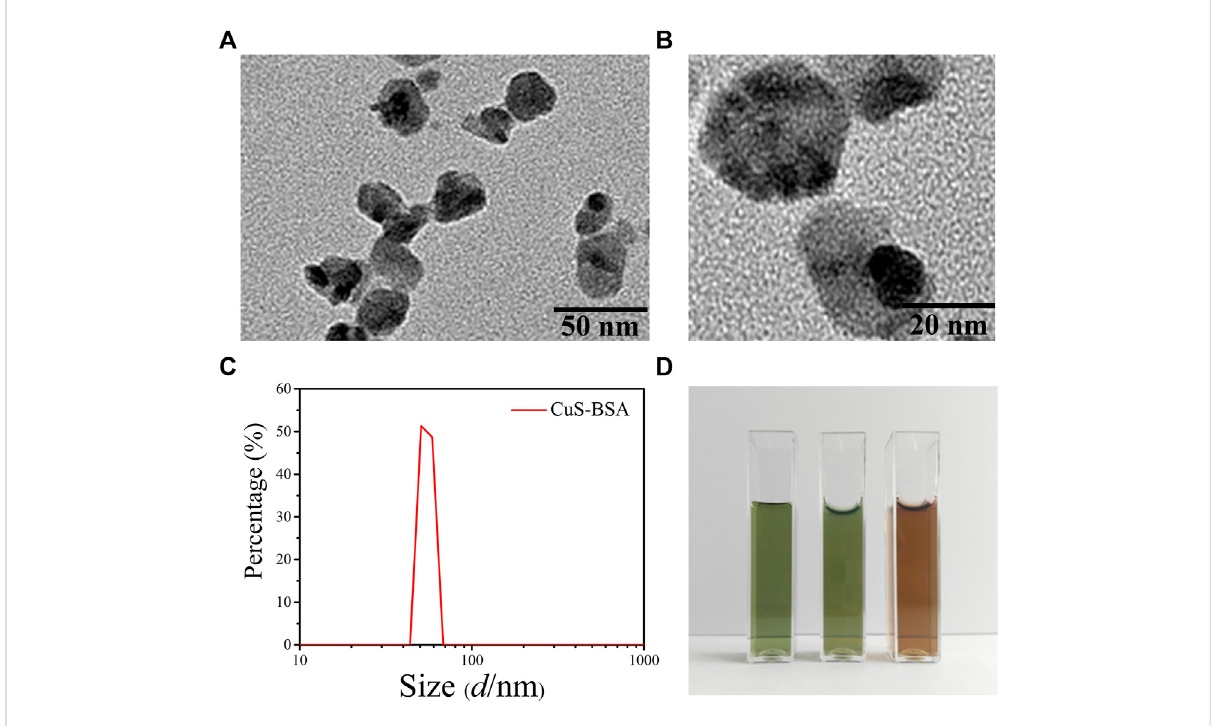
FIGURE 1 The characterization of CuS-BSA NPs. (A) and (B) The TEM images of CuS-BSA NPs. Scale bars are 50 nm and 20 nm, respectively. (C) DLS analysis. (D) Digital photosof dispersion solution of CuS-BSA NPs indifferent solvents. From left to right, the solvents were ultrapure water, PBS, and DMEM